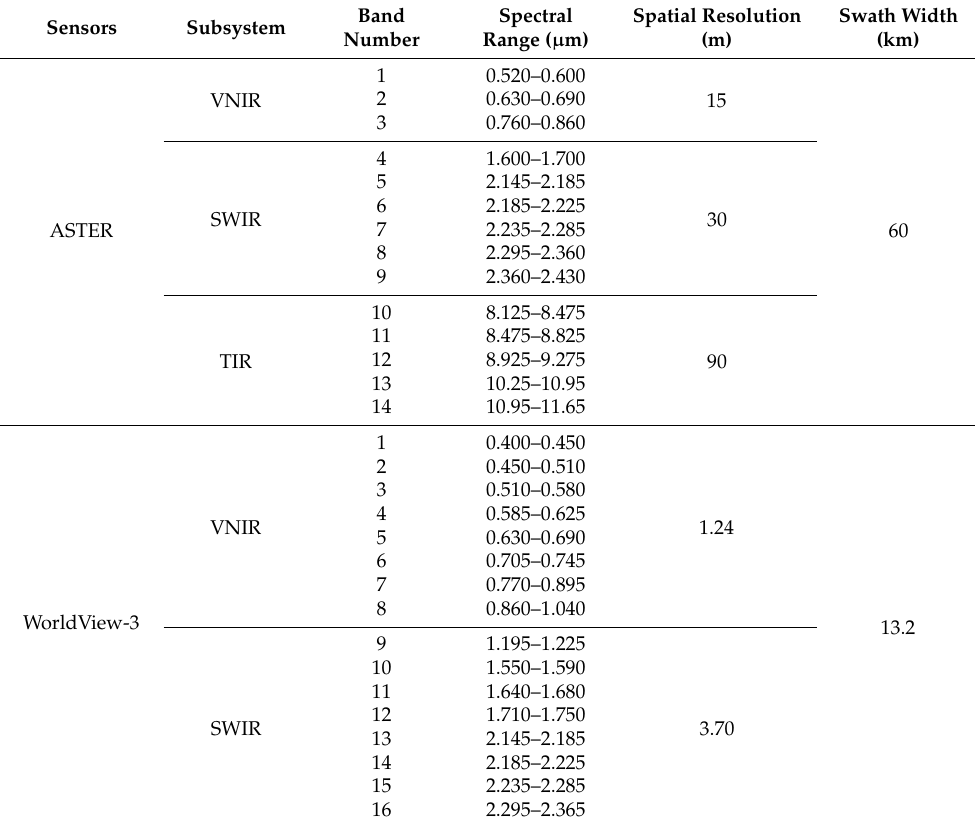
Table 1. Technical performance of the ASTER and WV-3